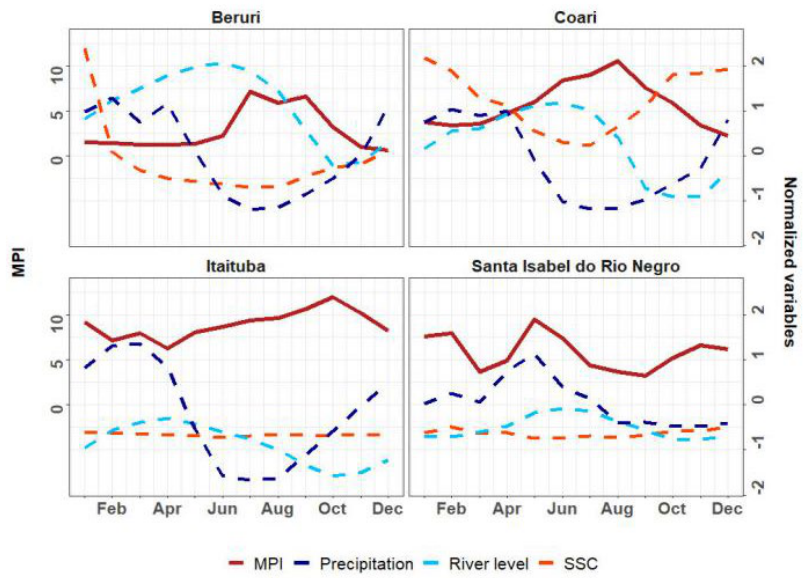
Figure 3. Median accumulated values for the years 2005 to 2013 of monthly parasitic malaria incidence (MPI) and normalized variables of suspended sediments concentration (SSC), river level, and precipitation for the study municipalities: Beruri, Coari, Itaituba, and Santa Isabel do Rio Negro.